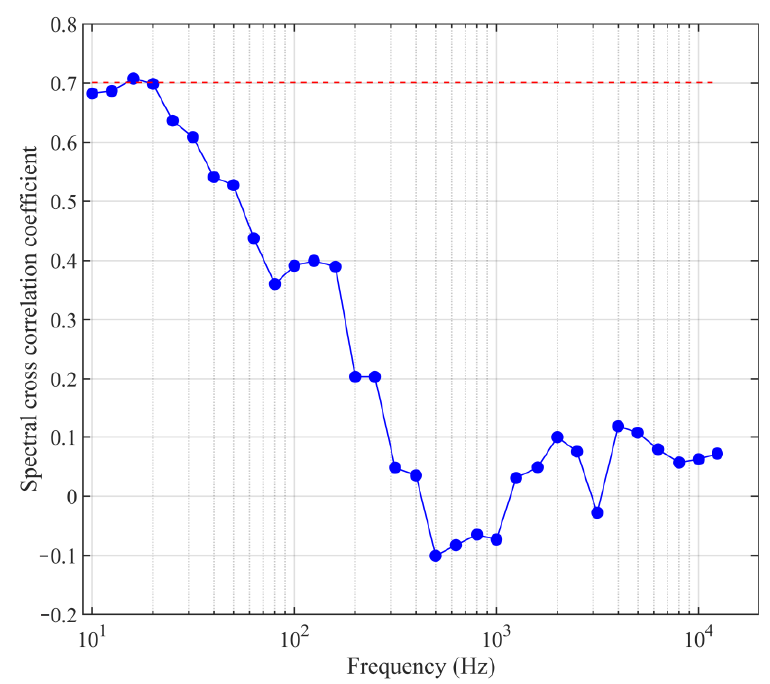
Figure 7. Spectral cross correlation coefficients between sea level and underwater noise level at various 1/3-octave frequencies.